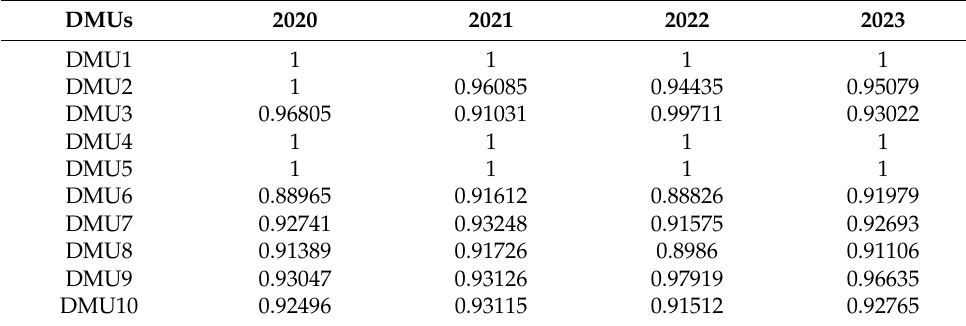
Table 9. The efficiency scores for DMUs in the prediction years